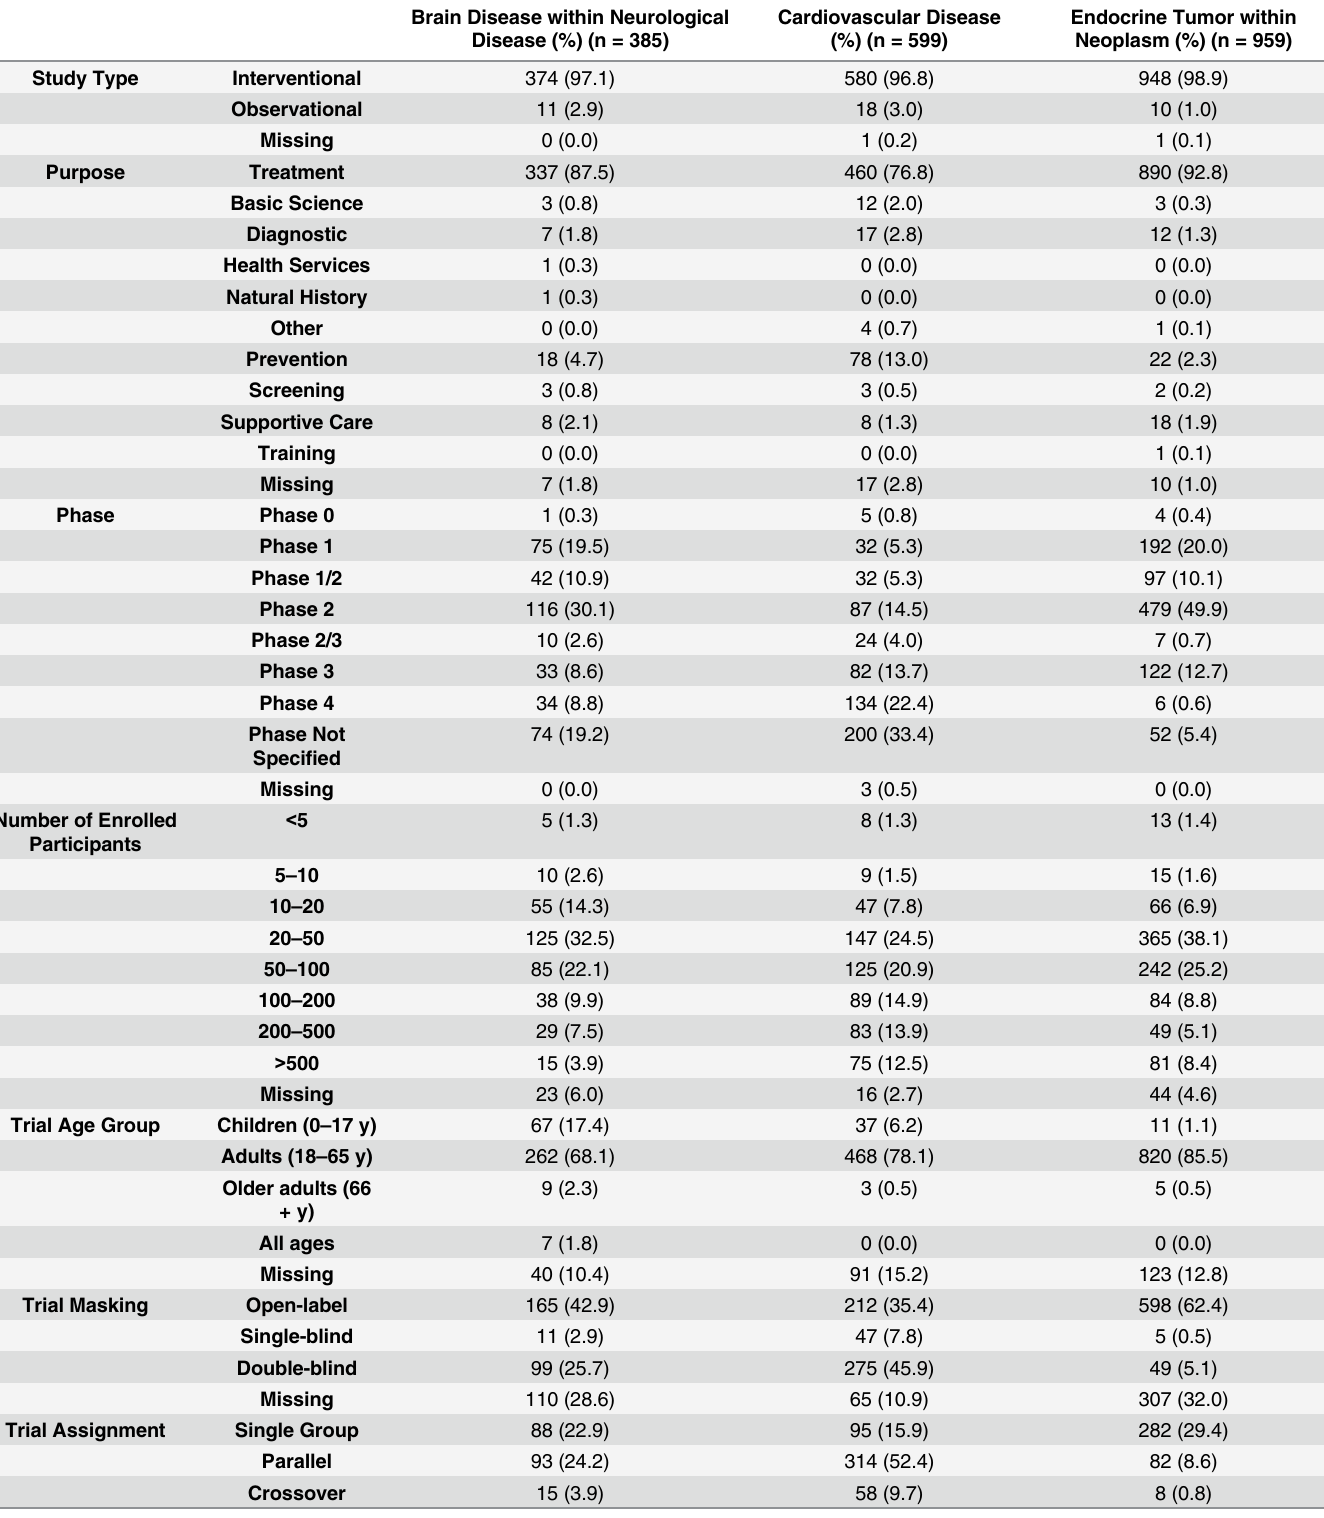
Table 2. Characteristics of A&G Studies Registered in ClinicalTrials.gov During